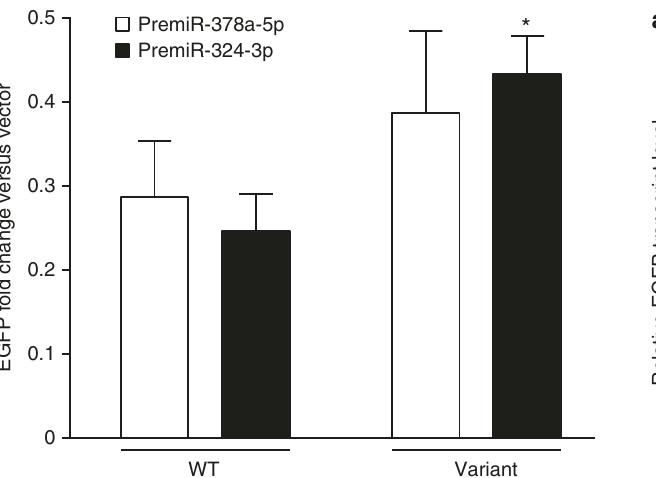
Fig. 4 EGFP reporter assay of interactions with microRNAs. Transient transfections with either the PremiR-378a-5p or PremiR-324-3p expression plasmid reduced the EGFP protein expression in cells harboring the wild type or variant allele equally (i.e., resulted in similar fold reductions). Transfection of PremiR-324-3p signi fi cantly increased the EGFP fl uorescence in the cells harboring the variant allele compared to the wild type ( P = 0.040). Data are expressed as mean fold change relative to the cells transfected with the pLV-miR vector, ±s.e.m., n = 9 replicates. P - values were calculated with unpaired t -test. * P < 0.05. N.B. the scale of the fold change on the Y axis is <1.0